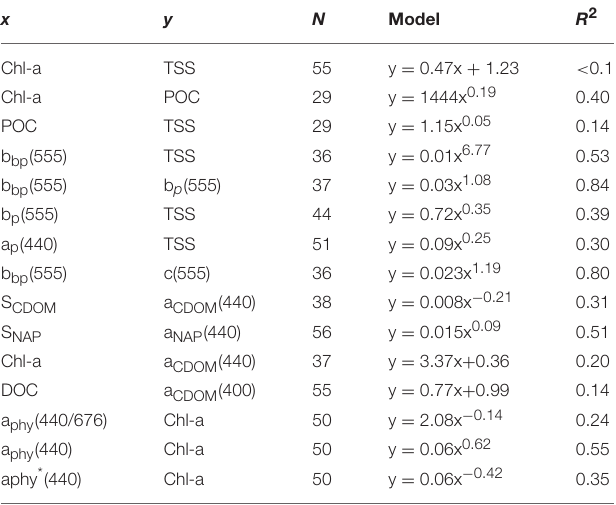
TABLE 5 | Summary of selected relationships.